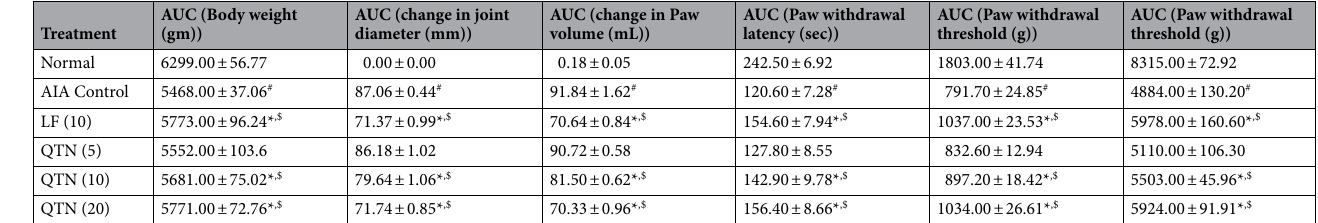
Table 1. Effects of QTN on FCA-induced alterations in body weight, change in joint diameter, change in paw volume, paw withdrawal latency, and paw withdrawal threshold (Von-Frey hair and paw pressure test). Values in parentheses indicate a dose in mg/kg (n = 6). Data were analyzed by one-way ANOVA followed by Tukey’s multiple comparisons test. For comparison with AIA-control group: * p < 0.05, comparison with normal group: # p < 0.05 and comparison with one another: $ p < 0.05. AIA adjuvant-induced arthritis, LF leflunomide, QTN 3,5,7,3 ′ ,4 ′ -pentahydroxy flavone, AUC area under